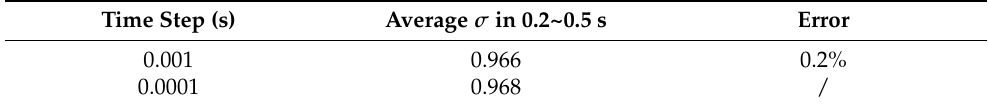
Table 2. Average total pressure recovery coefficient in 0.2~0.5 s.